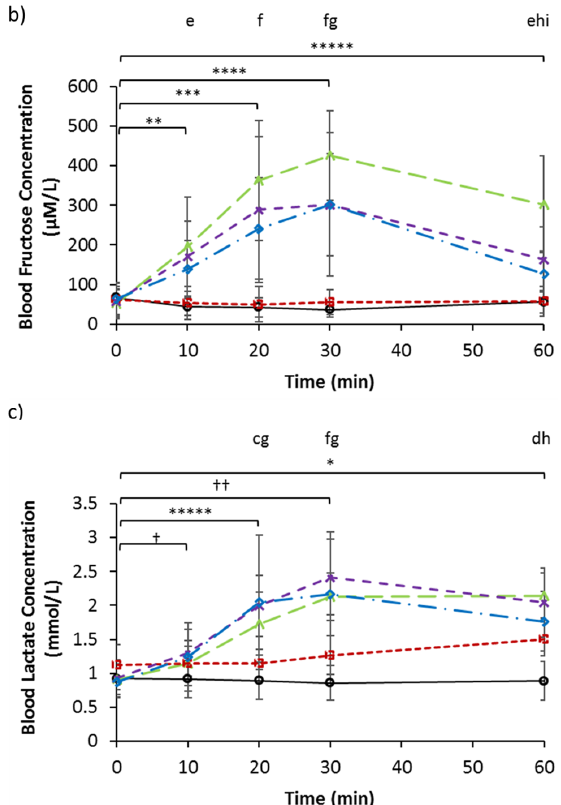
Figure 1. Serum ( a ) glucose ( b ) fructose and ( c ) lactate concentrations at baseline and following ingestion of 595 mL of water (W), 6% fructose (F), 6% glucose (G), 6% sucrose (S) and 6% combined glucose and fructose (C) solutions. a G, S, and C are greater than W; b G, S, and C are greater than F; c S is greater than F; d All carbohydrate trials are greater than W; e S is greater than G; f F is greater than W and G; g S is greater than W and G; h F is greater than G; I F is greater than C; * Increase from baseline